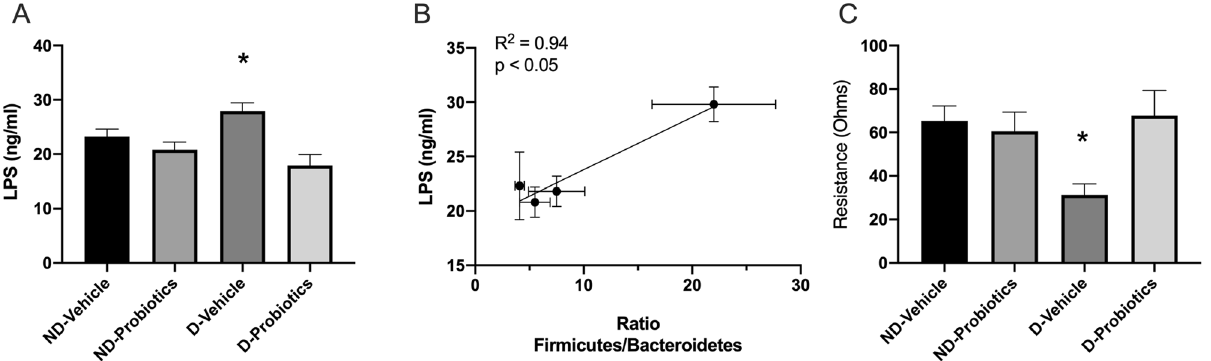
Figure 3. ( A ) Plasmatic concentrations of LPS in the different groups. *indicates a significant interaction between the main factors (Diet and Probiotics; p < 0.05). ( B ) Correlation between the ratio of Firmicutes/ Bacteroidetes and the plasmatic concentrations of LPS (ng/ml). To perform the regression, and since the measure were not performed in the same animals, we used the mean of the ratio and the infarct size for each group. ( C ) Gut barrier resistance (ohms) measured in the different groups with the Ussing Chambers. *p < 0.05 versus ND-vehicle and D-probiotics. ND none-dysbiotic D Dysbiotic.